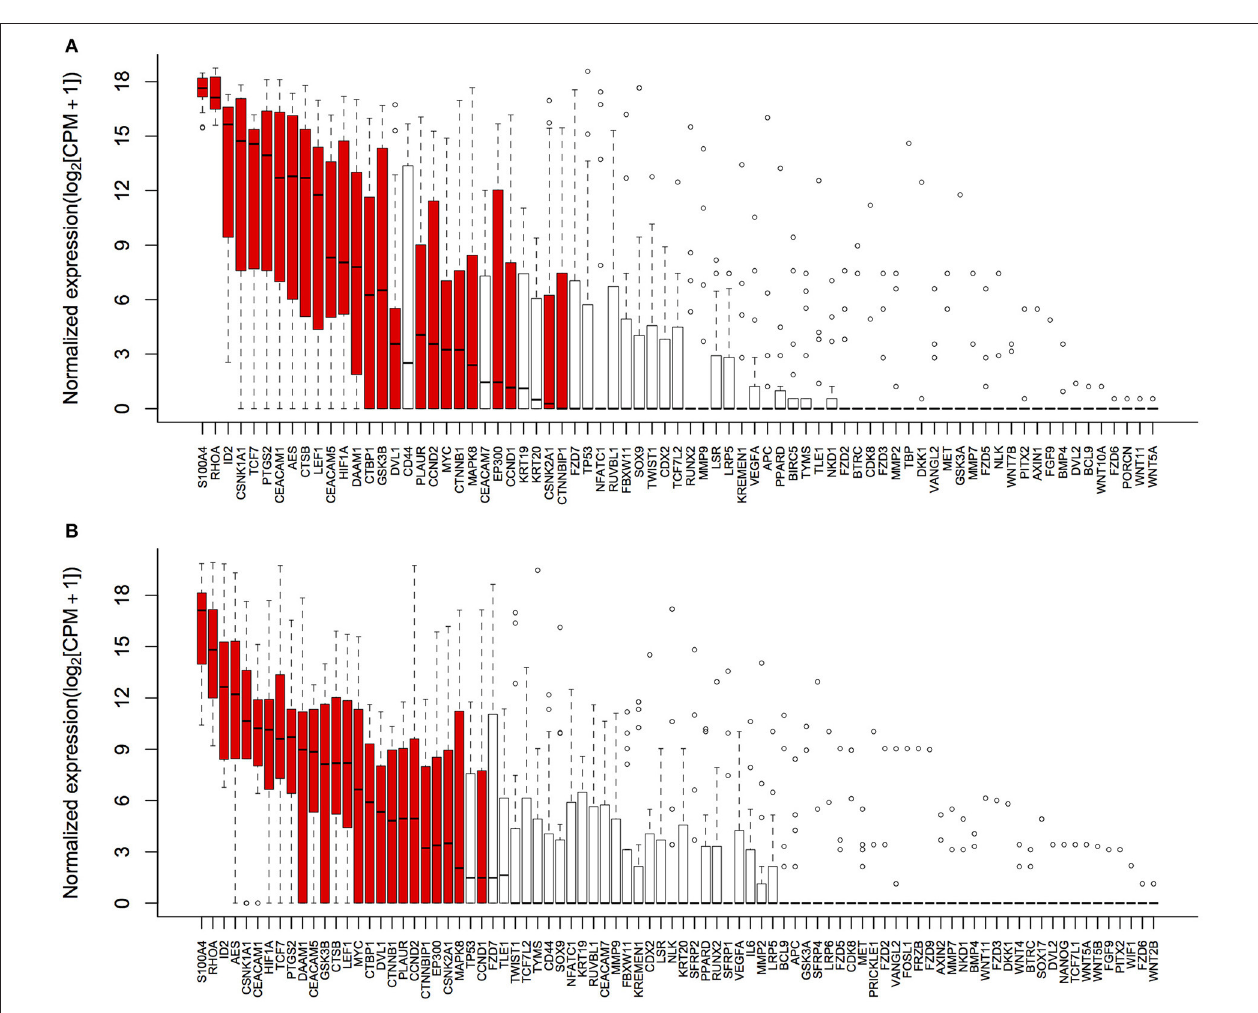
FIGURE 2 | Gene expressions in two centrifugal forces. Normalized expressions (log 2 scale) of genes were calculated as log 2 (CPM + 1) to avoid log transformation for zero CPM. (A) 75 genes were detectable in 3,500g; and (B) 86 genes were detectable in 1,600g followed by 16,000g. Box and whisker plots showed the interquartile range of log-transformed normalized expressions and outliers, and 25 passed filter genes were highlighted by red color.